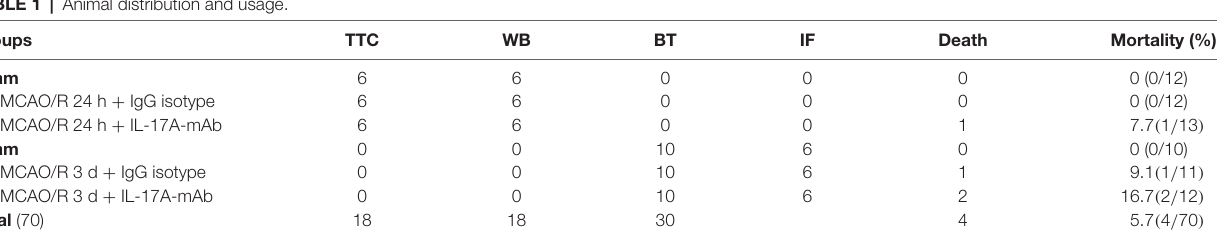
TABLE 1 | Animal distribution and usage.